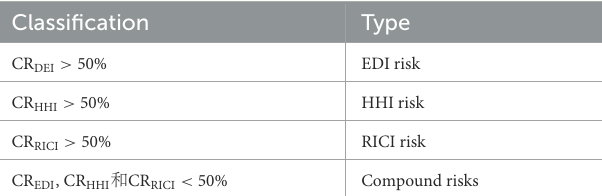
TABLE 2 Criteria for classification into dominant risk